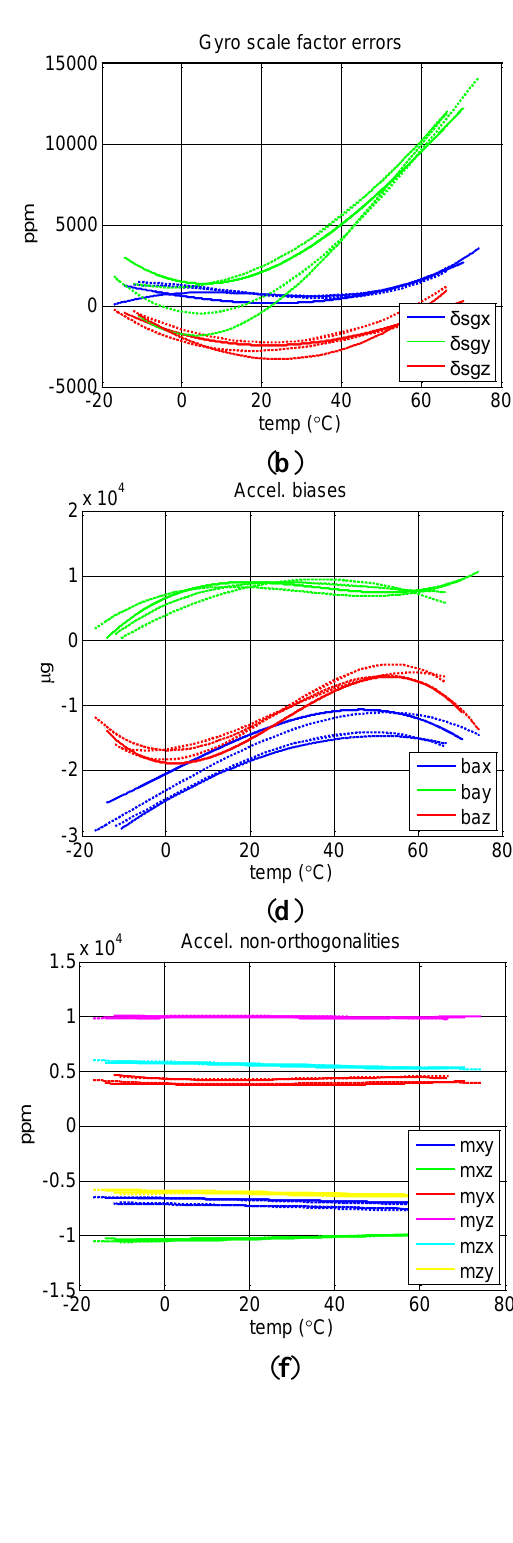
Figure 9. Thermal calibration results of NV-IMU100. In each subfigure, three dashed lines correspond to the results of the proposed method with three different temperature profiles, and the solid line is the result of the Soak